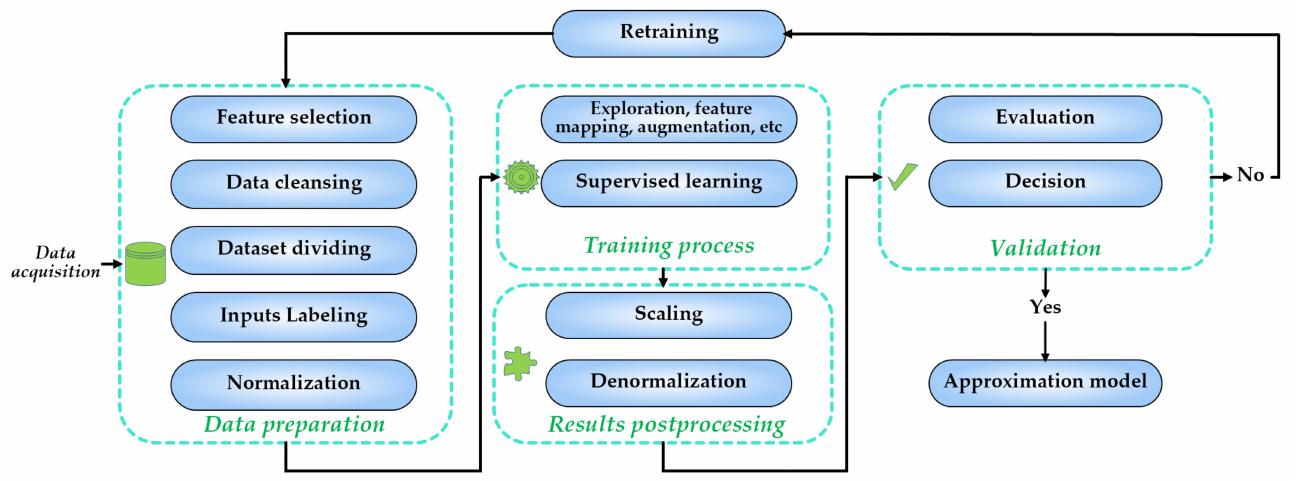
Figure 9. Different steps of constructing a machine learning predictive model. Reproduced from [57], Elsevier: